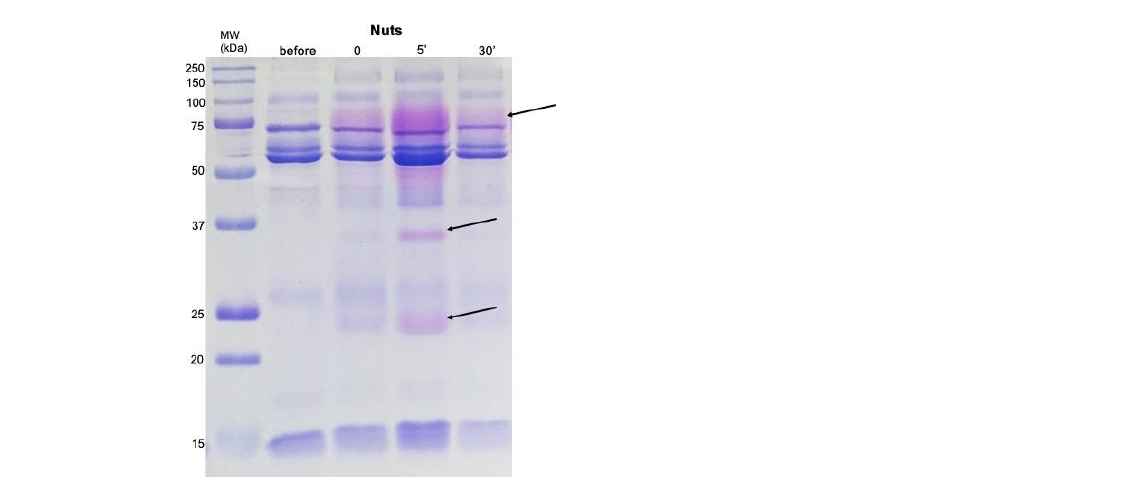
Figure 5. SDS-PAGE gel stained flowing Beeley’s protocol [25] for differential coloration of PRPs (arrows). Samples obtained from walnuts snack are presented as example.